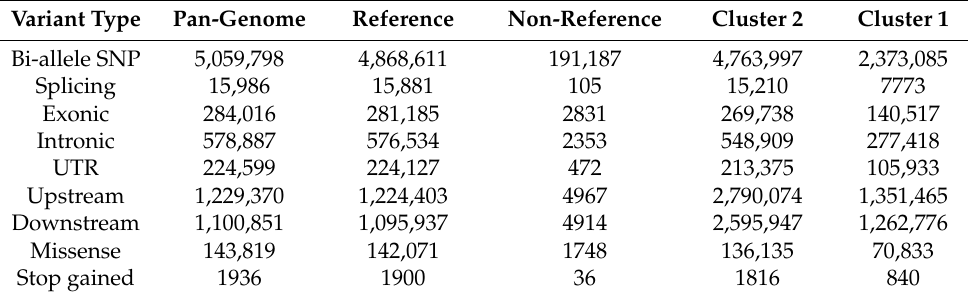
Table 1. Classification of the SNPs detected in the rice